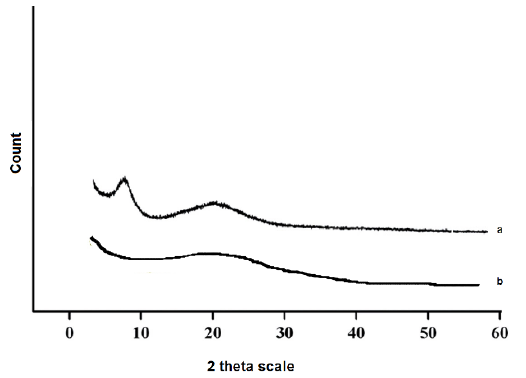
Figure 5. XRD diffraction patterns, gelatin (a), and the prepared sponge (b).